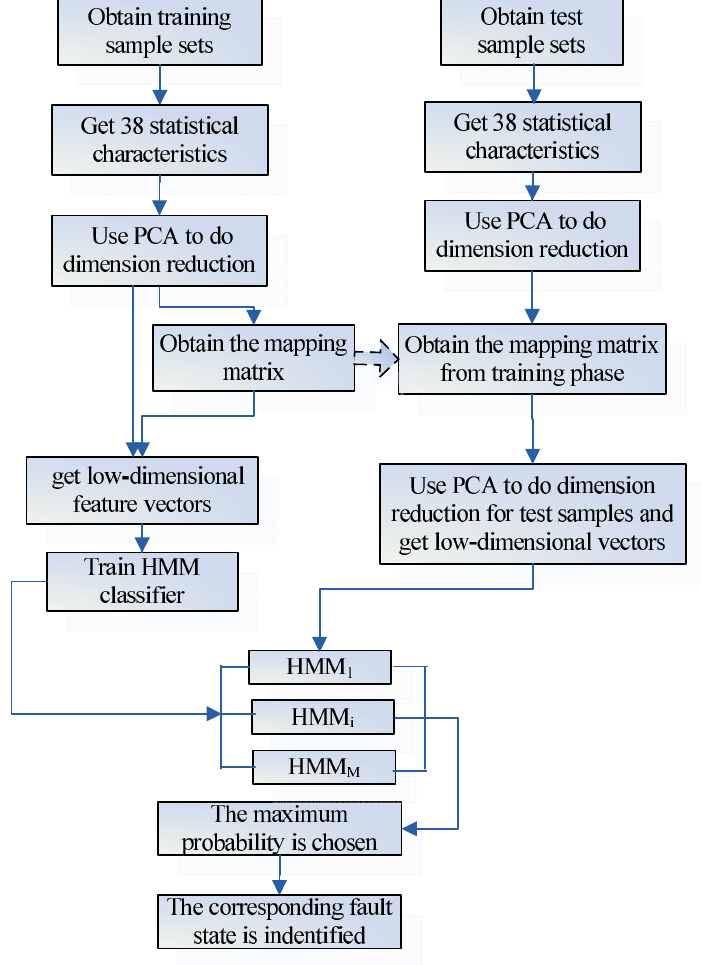
Fig. 1 Proposed scheme for fault diagnosis.